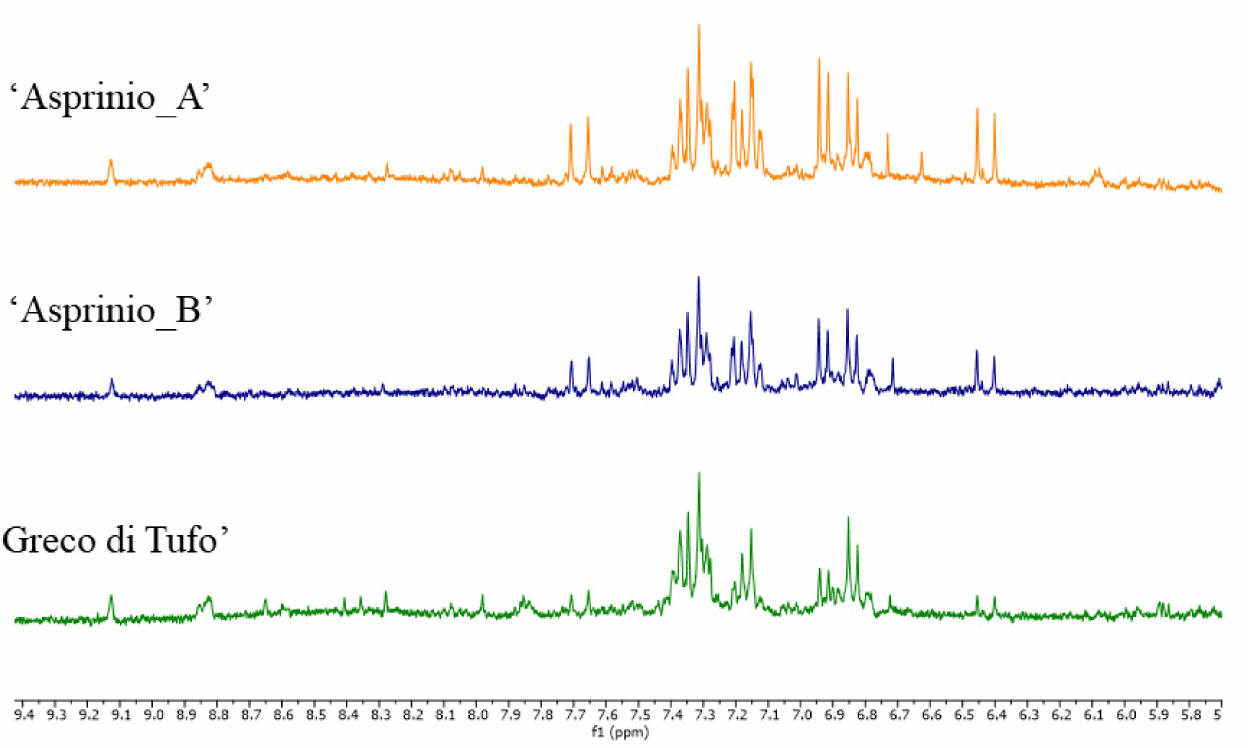
Figure 4. 1 H NMR spectra of 3 representative samples of ‘Asprinio_A’, ‘Asprinio_B’ and ‘Greco di Tufo’, details of the aromatic